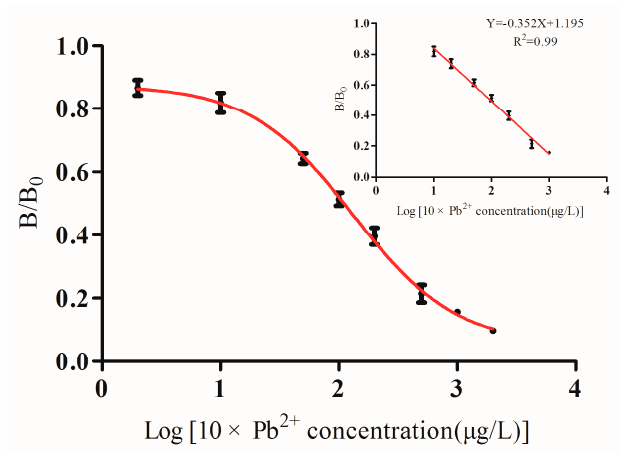
Figure 2. Standard curve of the competitive ELISA for lead ions.